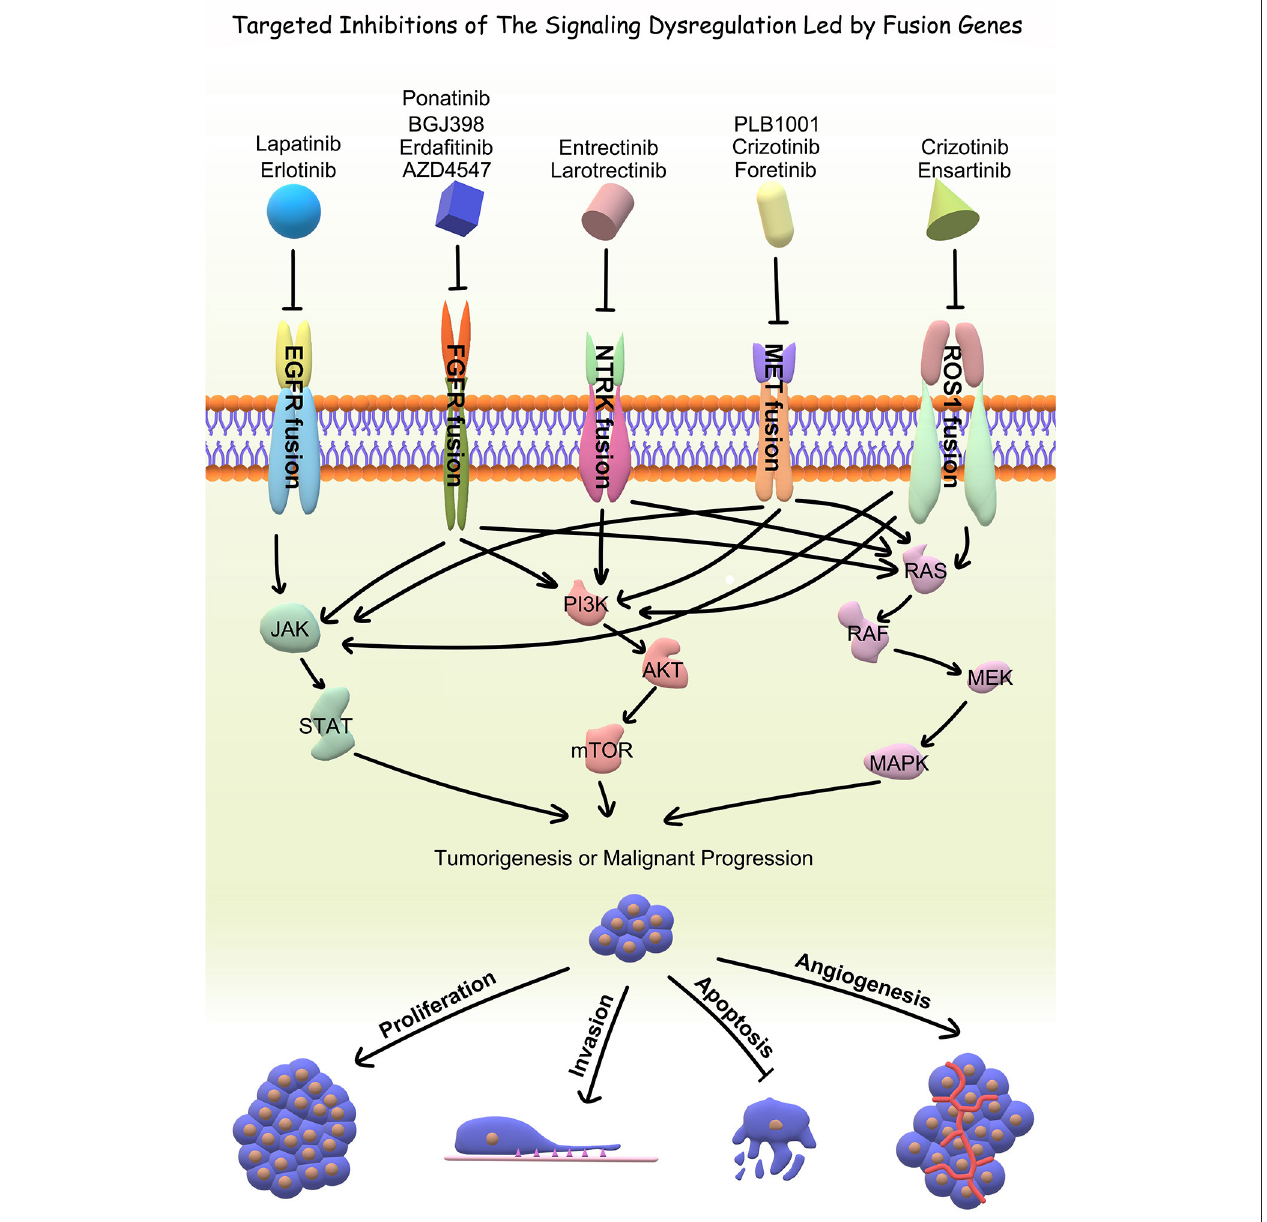
FIGURE 4 | Downstream pathways related to specific driver fusions and targeted inhibitors.